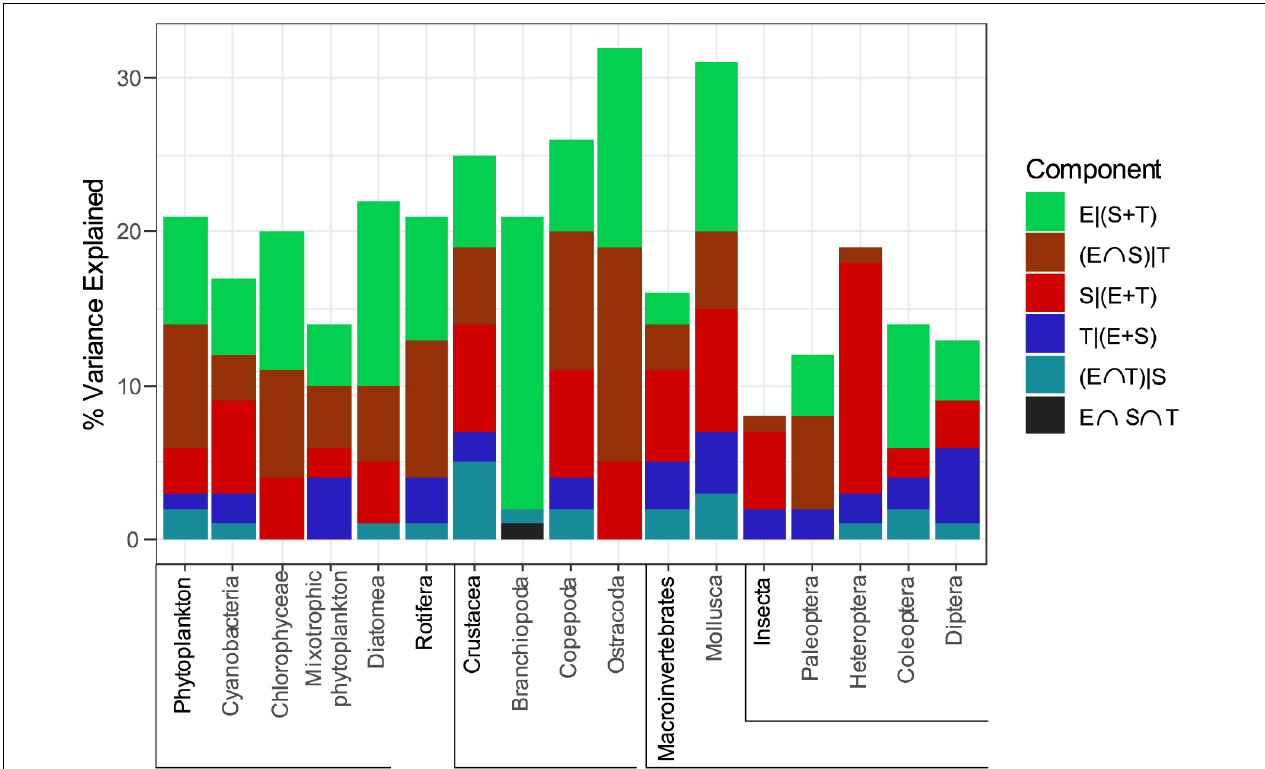
FIGURE 2 | Results of variation partitioning analysis for each group of organisms. The percentage of variation explained by each component is represented with a different color (green: pure environment; brown: environment-space overlap; red: pure space; dark blue: pure time; cyan: environment-time overlap; black: environment-space-time overlap). Only significant components ( P < 0.05) are shown. Taxa in bold type include species from the following underlined groups.